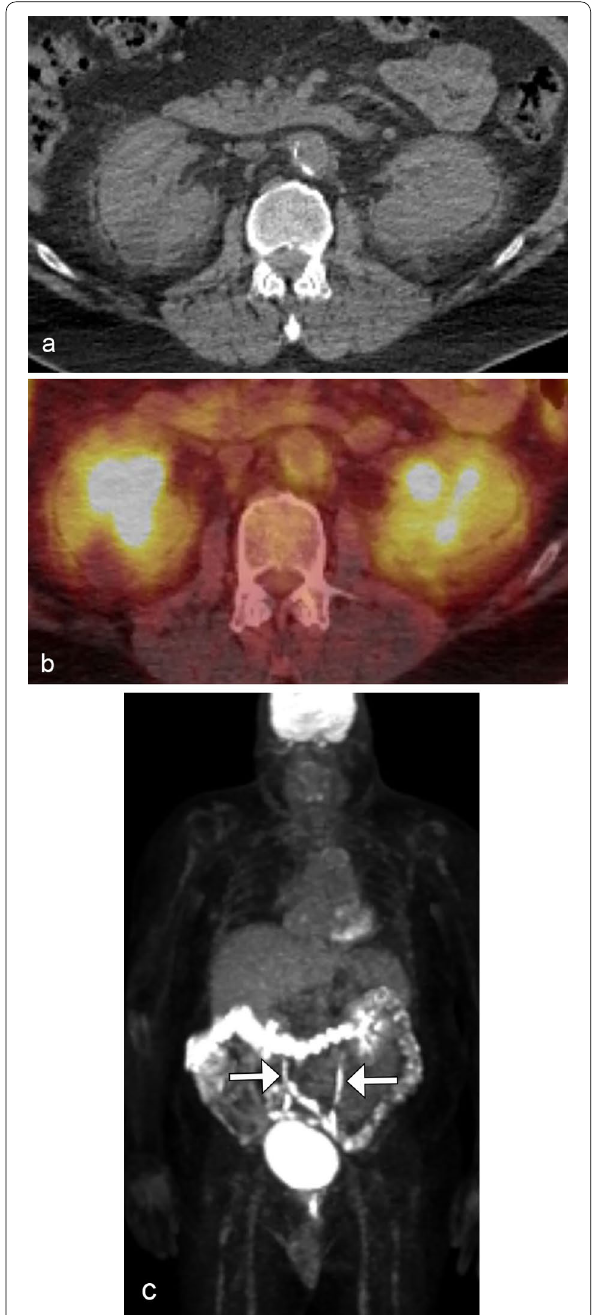
Fig. 14 Erdheim–Chester disease. Axial noncontrast CT ( a ) demonstrates bilateral perinephric soft tissue stranding/infiltration mimicking the perinephric infiltrative appearance of lymphoma. F18-FDG PET/CT images ( b , c ) demonstrate the low-grade metabolic activity associated with soft tissue stranding. Note the normal course of the bilateral ureters (arrows). The patient was also found to have thoracic periaortic soft tissue thickening and bilateral metadiaphyseal sclerosis which are additional features of Erdheim–Chester disease